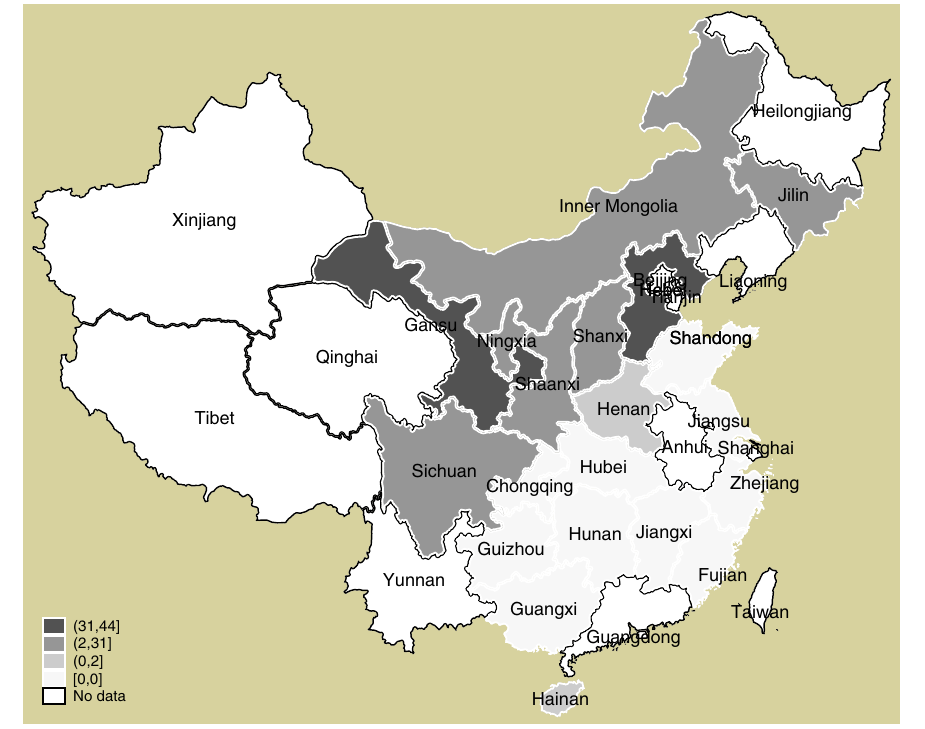
Fig. 4 Distribution of counties selected for PV poverty alleviation policy in China mainland. This fi gure is drafted with 211 sample counties in 2016. The number of photovoltaic counties in each province is calculated. The color depth indicates the size of the number, and the name of the provinces has been marked. There are missing data in some provinces including Qinghai and Tibet, although SEPAP programs have been implemented in these area. Source data are provided in the Source Data fi